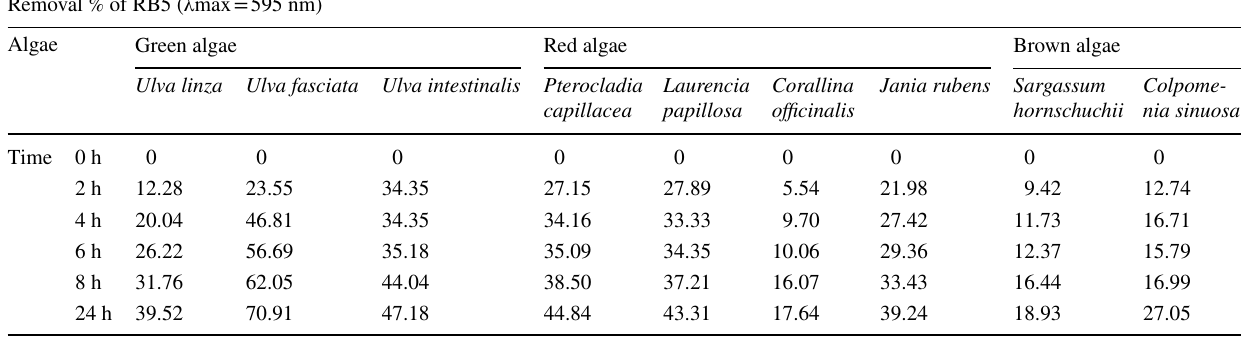
Fig. 6 Removal percentage of Reactive Black 5 by the nine studied dried algal